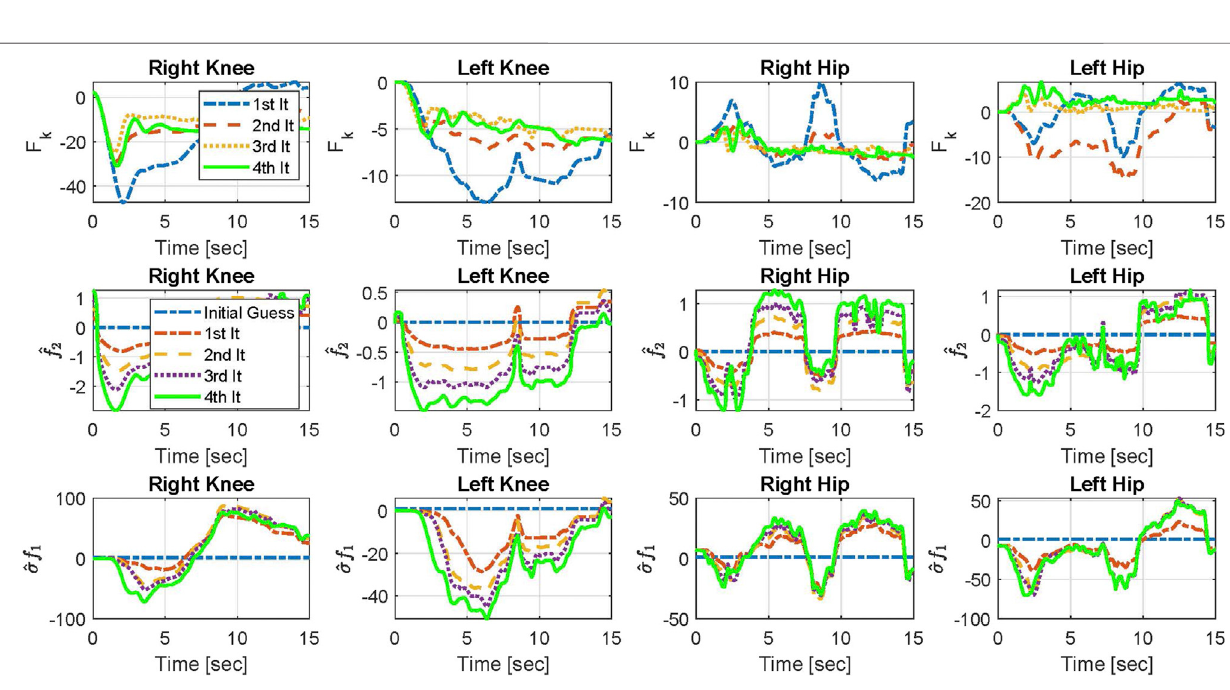
Frontiers in Robotics and AI |